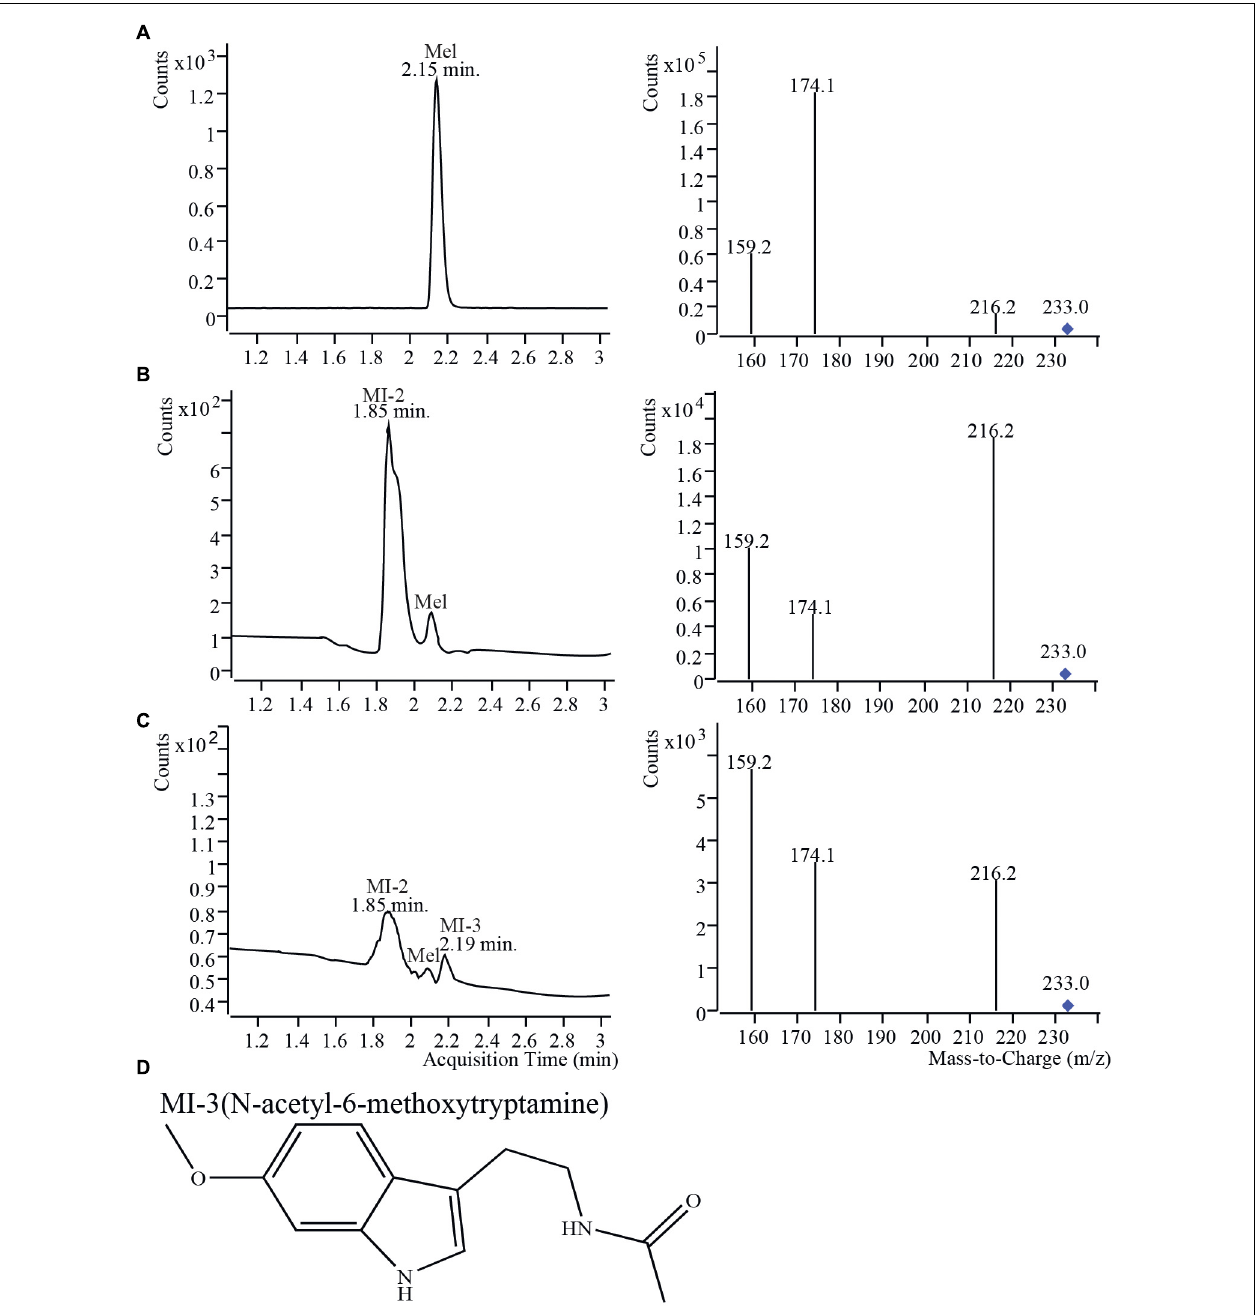
FIGURE 2 | Mass spectra of mulberry leaf and fruit samples from “Dashi” harvested in 2017 detected using UPLC-MS/MS. (A) Melatonin standard; (B) Mulberry fruit; (C) Mulberry leaves; (D) The structure of a melatonin isomer. MI-3, N